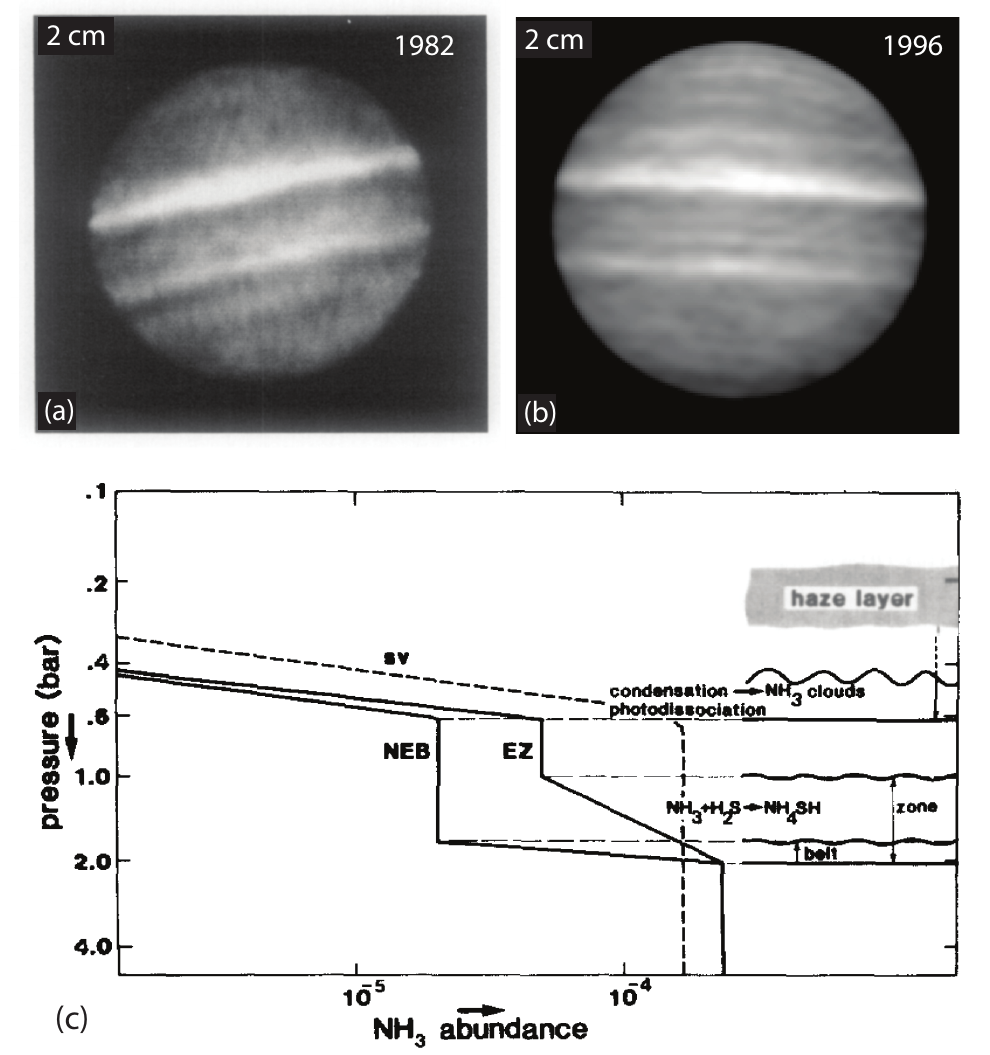
Figure 5. ( a ) VLA radio map of Jupiter at a wavelength of 2.0 cm, taken in 1982–1983 (combining C and D array configurations). The resolution is 1.2” and the disk size 32.0”. The bright North and South Equatorial Belts (NEB, SEB) are clearly visible [95]. ( b ) VLA radio map of Jupiter at 2 cm taken in January 1996 at a spatial resolution of 1.4” East-West and 0.9” North-South. Brightness temperatures between 120 and 167 K are shown. In addition to the NEB and SEB, several other belts/zones are visible [52]. ( c ) The altitude distribution of ammonia gas in the NEB and EZ as derived from VLA maps at 1–6 cm taken in 1982–1983 (e.g., panel a ). The various cloud layers are sketched on the right side; the saturated vapor curve for ammonia gas of solar concentration is indicated by the line sv